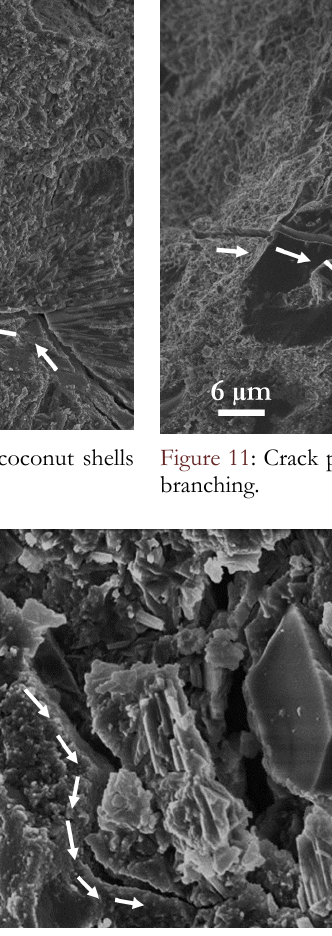
Figure 12: Crack propagation in cement composite